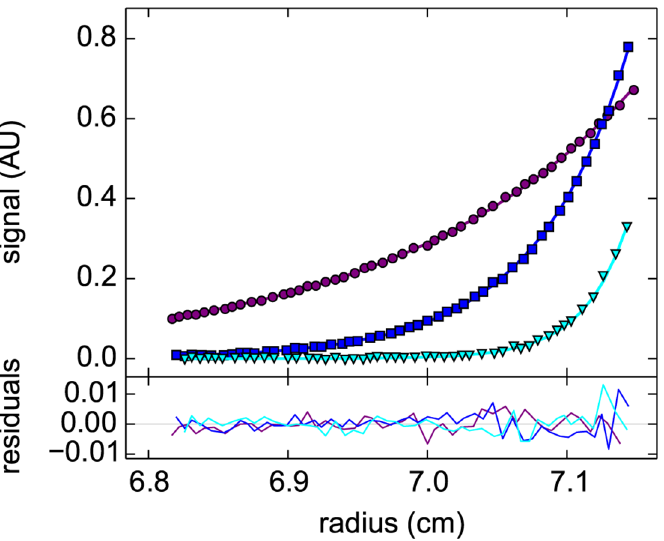
Fig 2. Radial concentration distribution in a sedimentation equilibrium experiment with enhanced green fluorescent protein in a “ prime gray ” photopolymer centerpiece. Data were acquired with the absorbance detection sequentially at rotor speeds of 15,000 rpm (purple), 24,000 rpm (blue), and 35,000 rpm (cyan) (symbols, only every 5 th data point shown). A global model (lines) results in an apparent molar mass of 29.7 kDa with a root-mean-square deviation (rmsd) of 0.0032 OD 489 , and residuals as shown in the lower plot.